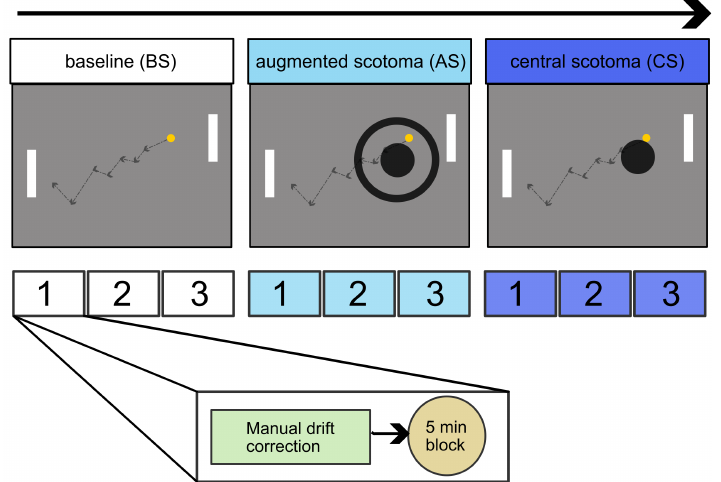
Figure 1. Diagram flow of the study. First, the participants played a baseline (BS) game condition using their normal vision. During gaming, the ball followed a random trajectory (dotted line). Afterward, the augmented scotoma (AS) was presented, showing either a monocular cue or binocular distortion augmentation around the scotoma. The current figure showcases the monocular ring augmentation. The last condition was the central scotoma simulation (CS). Each condition has three repetitions (1, 2, and 3) containing the manual drift correction and a 5 min